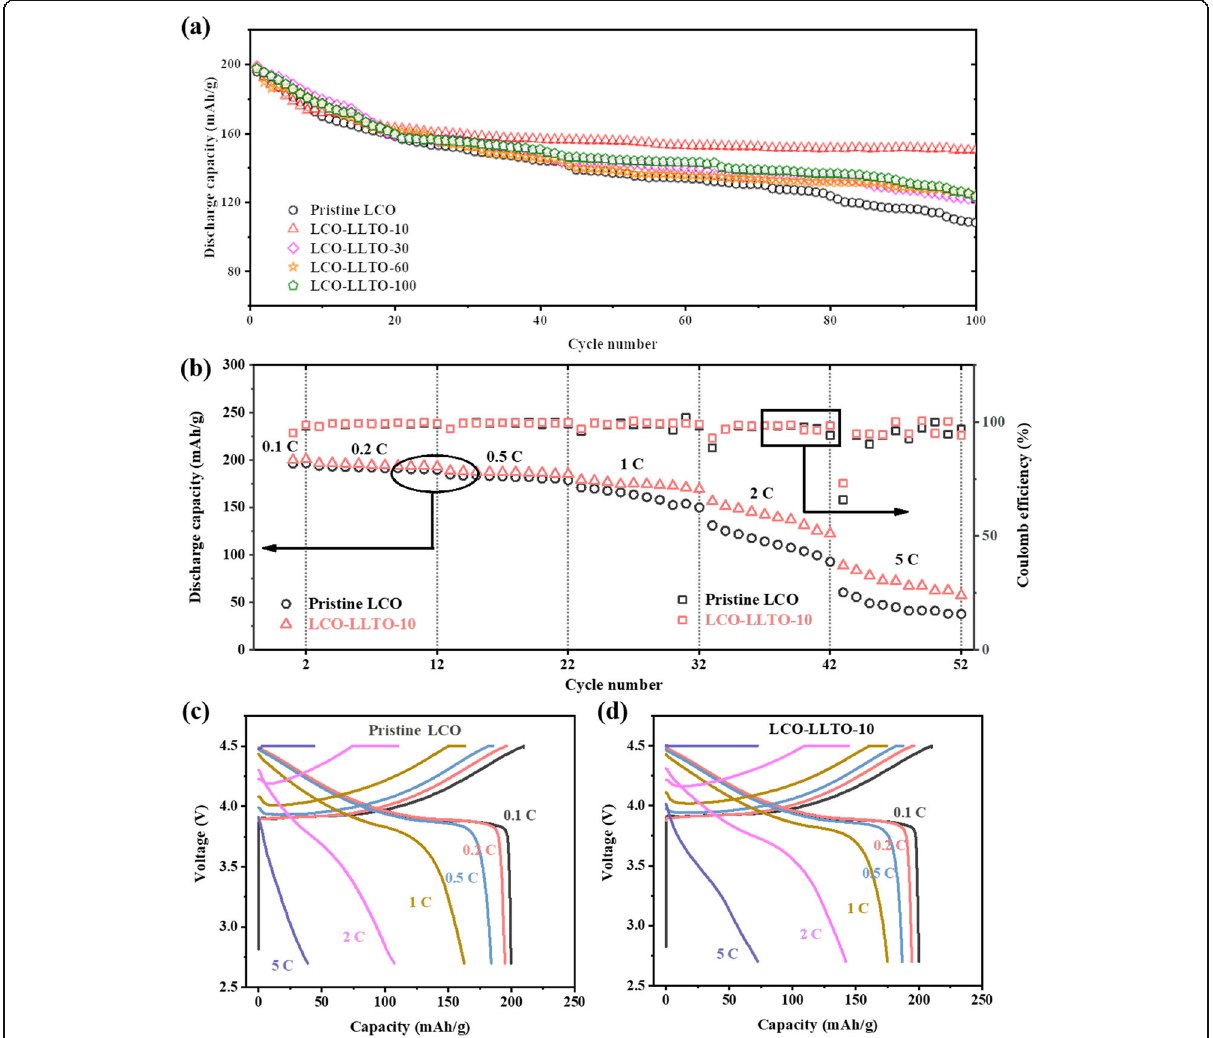
Fig. 2 a Cycle performances of electrodes based on pristine LCO and that modified by α -LLTO with different deposition time; b Rate performances of pristine LCO and LCO-LLTO-10; c , d Voltage vs. capacity plots of c pristine LCO and d LCO-LLTO-10 at the different cycling rates